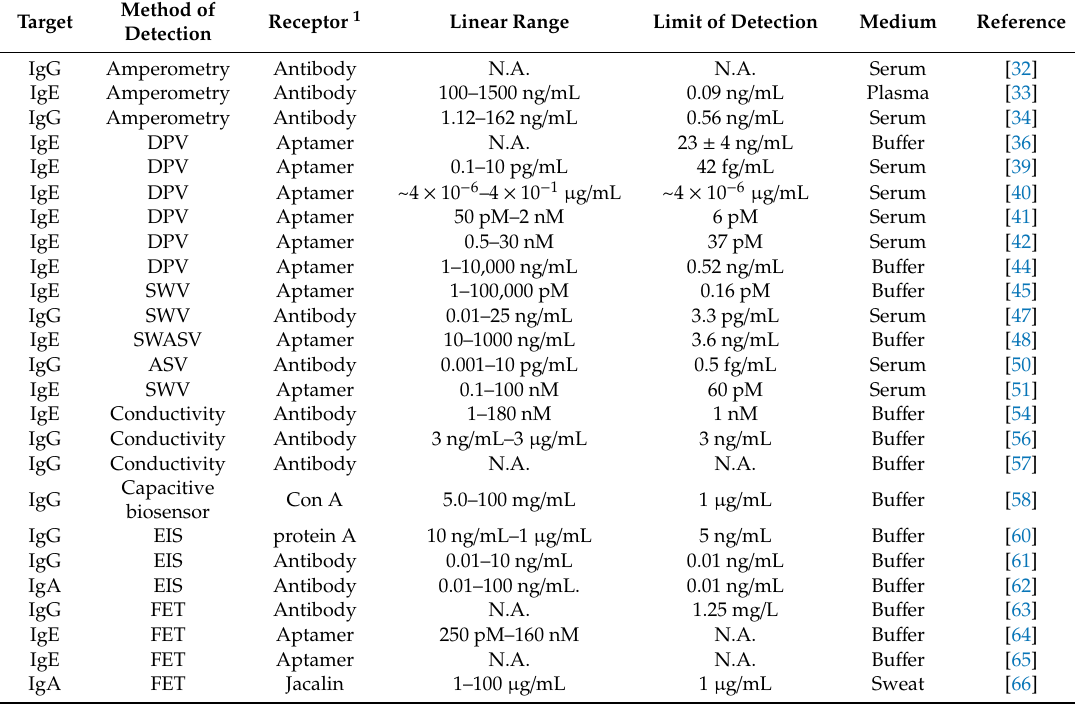
Table 2. Characteristics of the electrochemical biosensors for detecting immunoglobulins (N.A. not